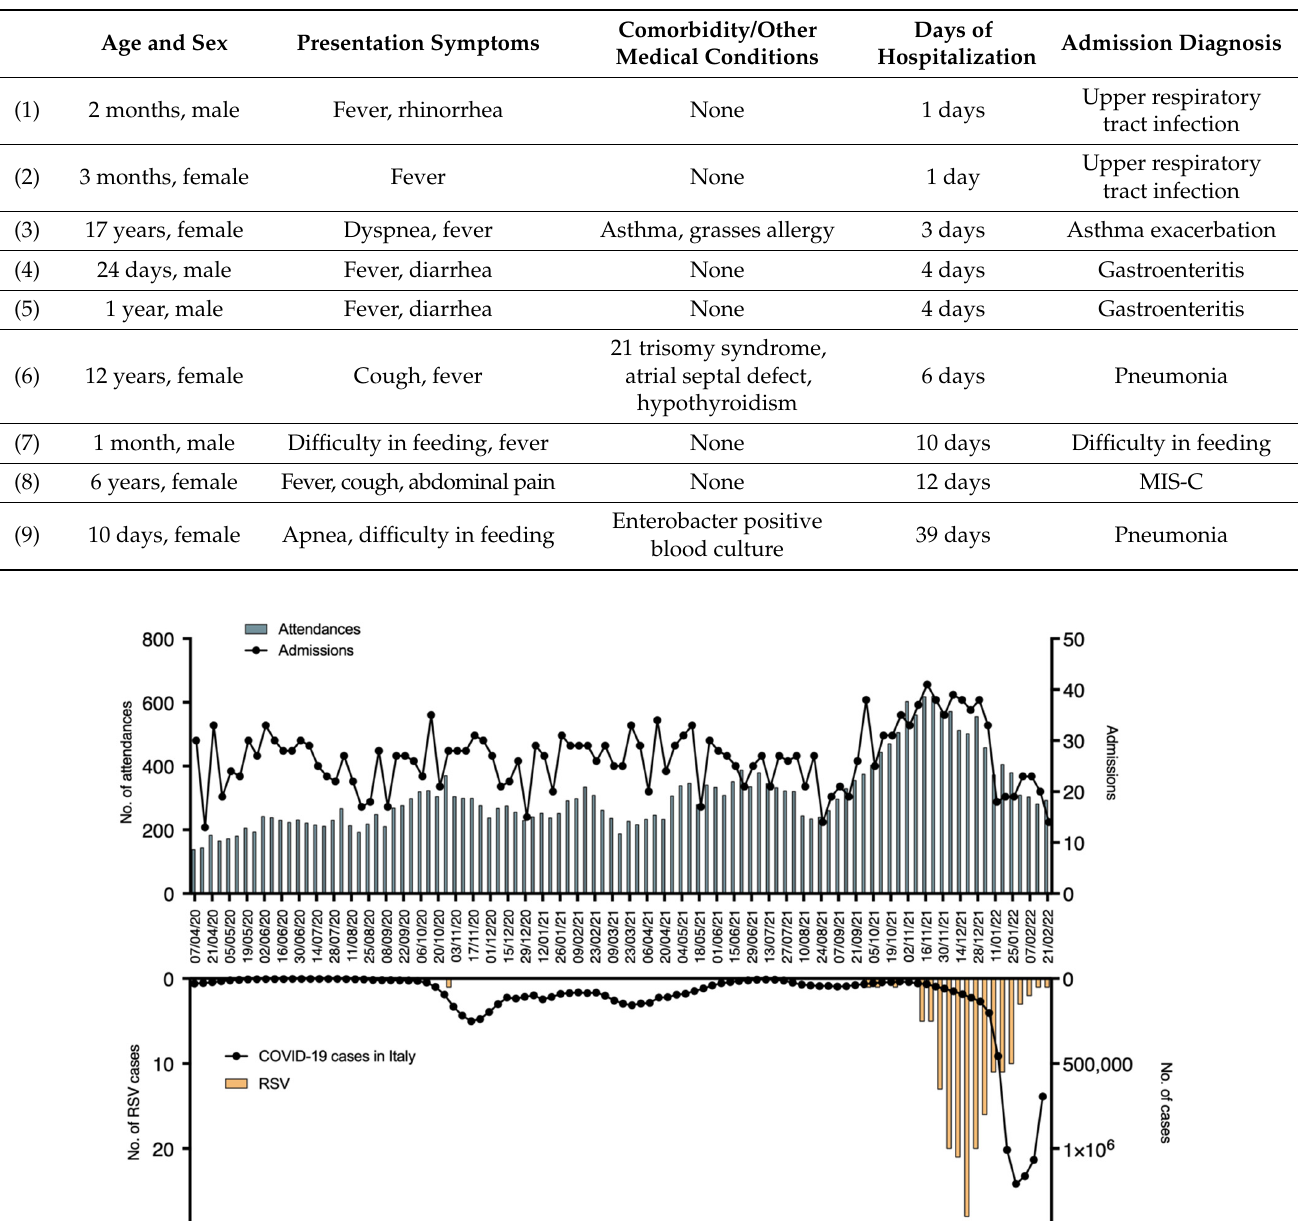
Table 1. Clinical features of the 8 patients admitted for COVID-19 related symptoms.